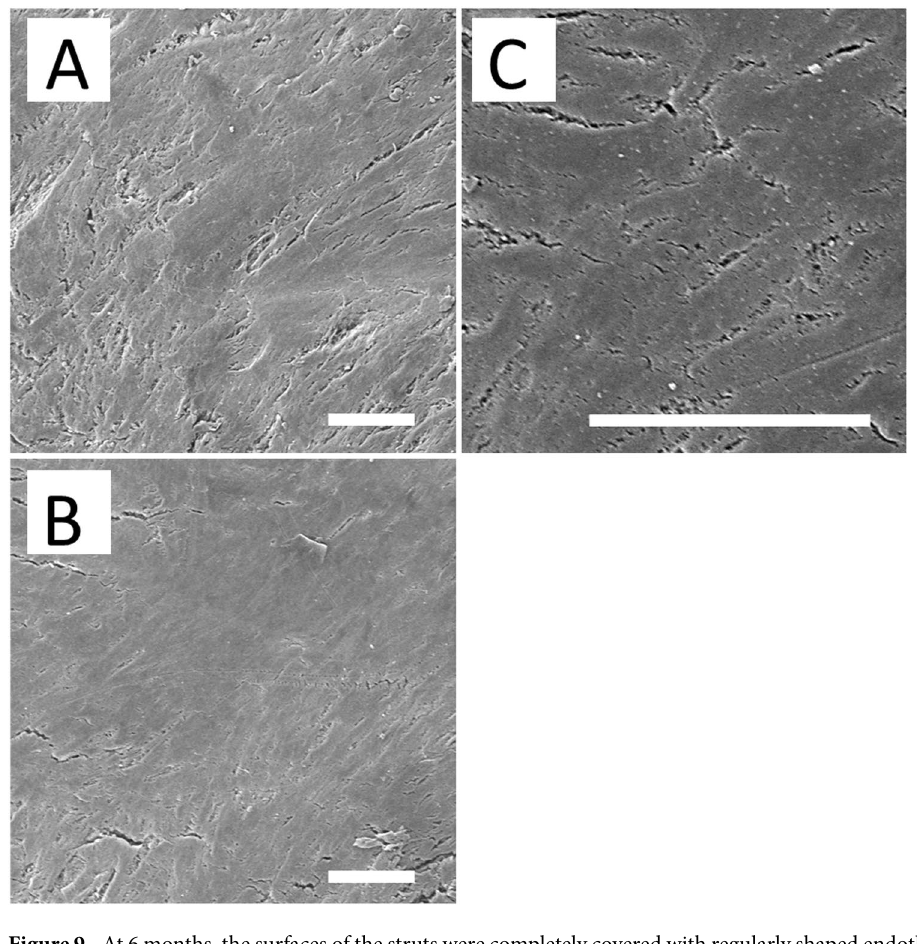
Figure 9. At 6 months, the surfaces of the struts were completely covered with regularly shaped endothelia in close contact with each other in Group A and B (300X) ( A and B ). Furthermore, re-endothelialization on the surfaces of struts among and the endothelia of group A were aligned in the direction of the flow (1000X) ( C ). (Scale bar = 50 μ m).